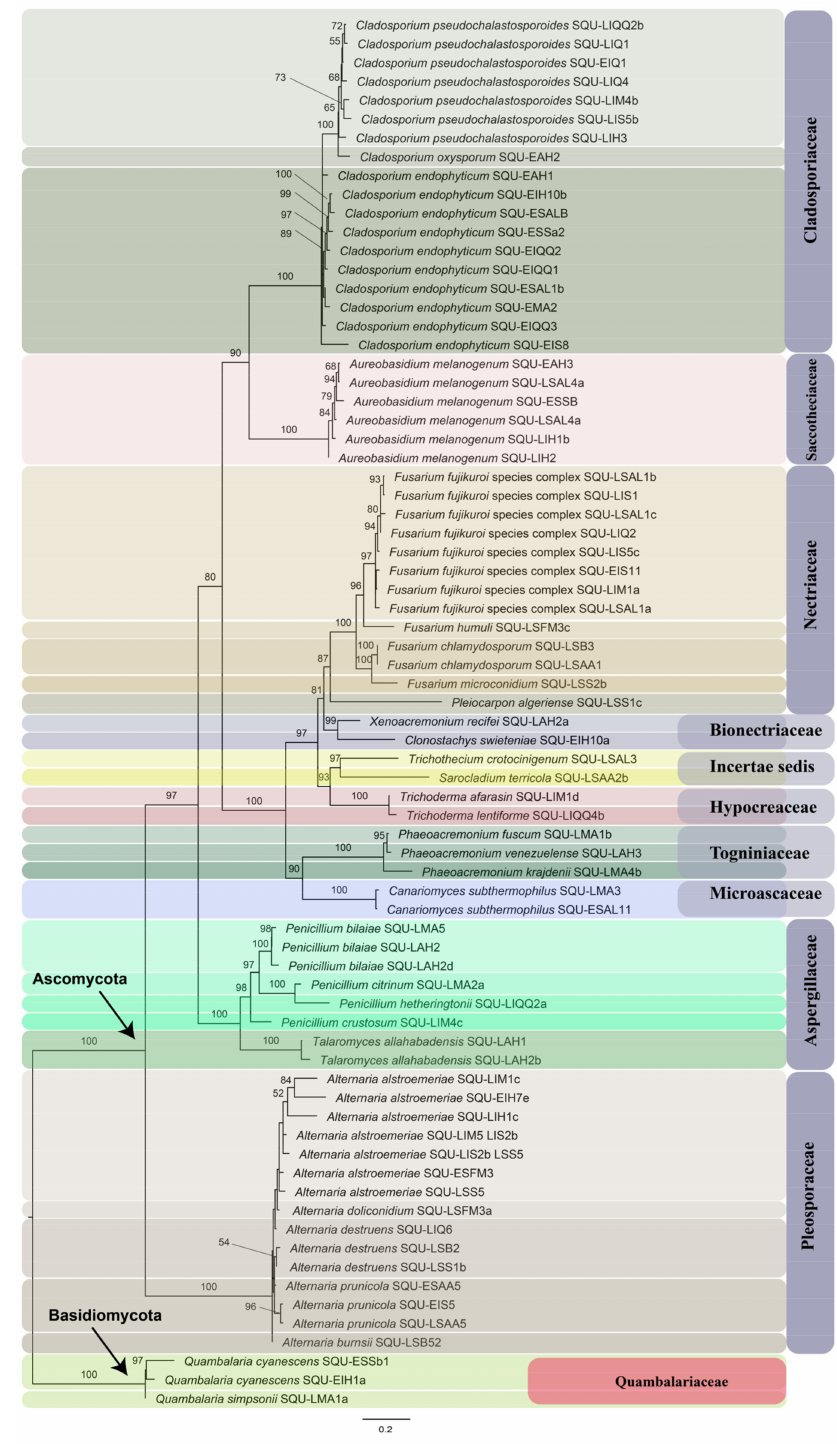
Figure 1. Maximum likelihood phylogenetic tree of individual fungal isolates obtained in this study. The phylogeny is based on the ITS sequences generated during this study, each species of individual genus is highlighted in similar color shade. The taxa represent nine families of Ascomycota and one of Basidiomycota. Two genera Sarocladium and Trichothecium are in Incertae sedis following the modern classification system of fungi [36]. The numbers on branches are the bootstrap